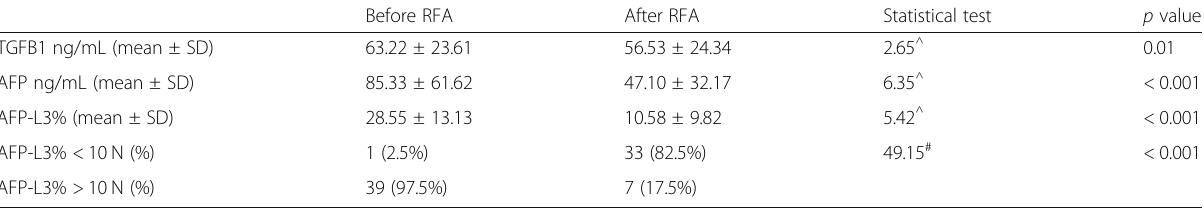
Table 1 TGFB1, AFP, and AFP-L% before and after radiofrequency in patients ’ group